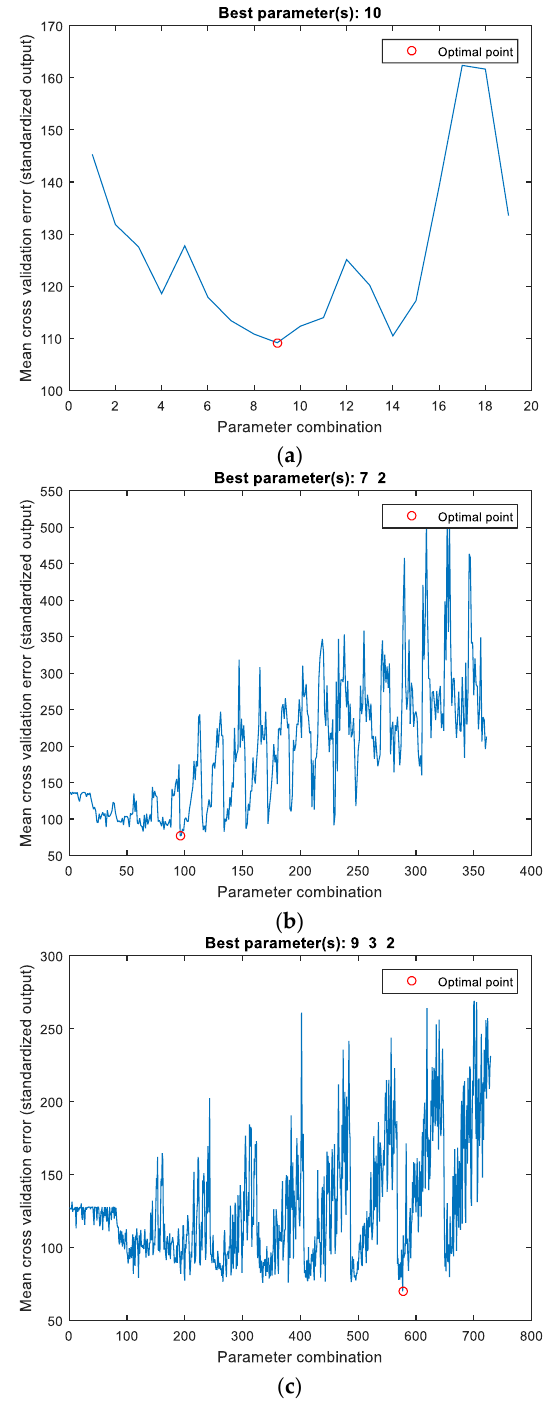
Figure 6. Determination of the best ANN model with ( a ) one hidden layer, ( b ) two hidden layers and ( c ) three hidden layers.